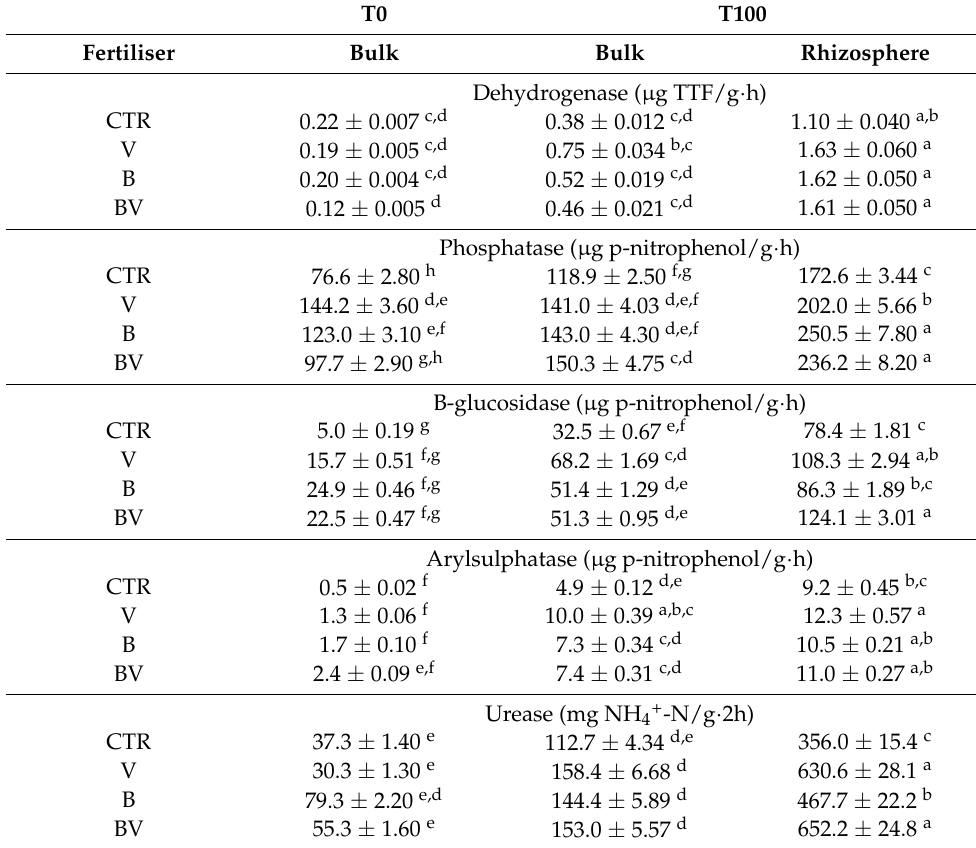
Table 4. Enzyme activities of bulk and rhizosphere soils amended with different fertilisers at the start (T0) and end (T100) of tomato cultivation. V—vermiwash; B—biochar; BV—biochar together with